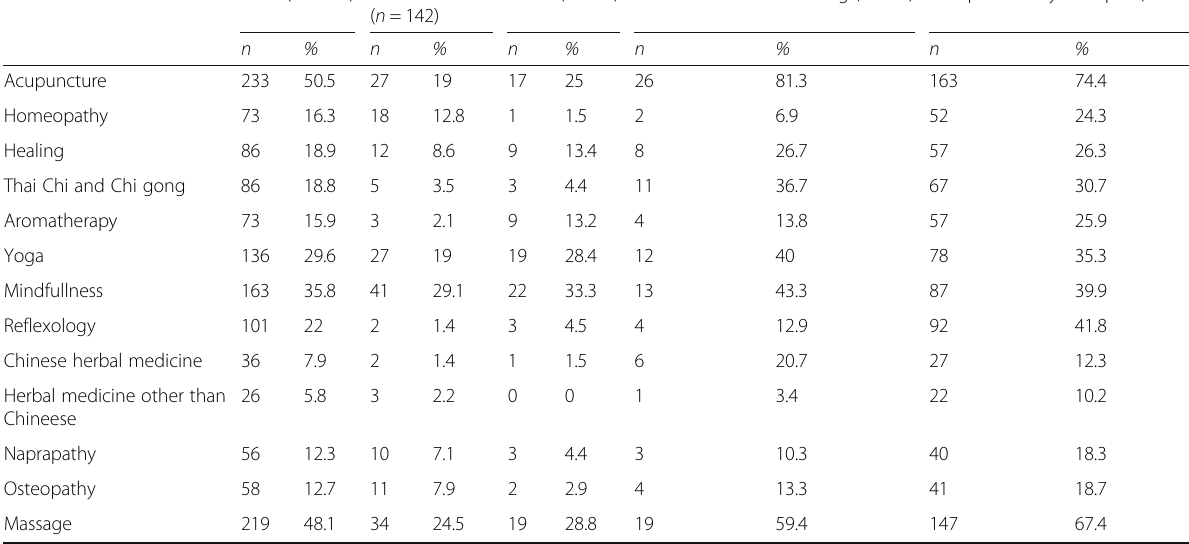
Table 1 Good knowledge of complementary